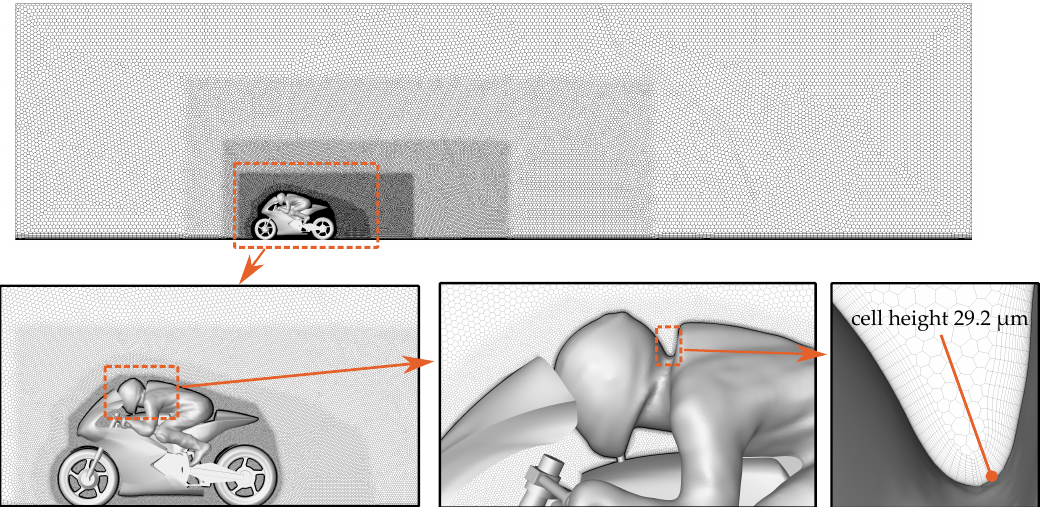
Figure 4. Details of the mesh for RANS and SAS simulations with a highlighted boundary layer consisting of 26 prisms of which the first cell is 29.2 µ m high ( y + ∼ 1), while the entire computational domain consists of 30.9 million